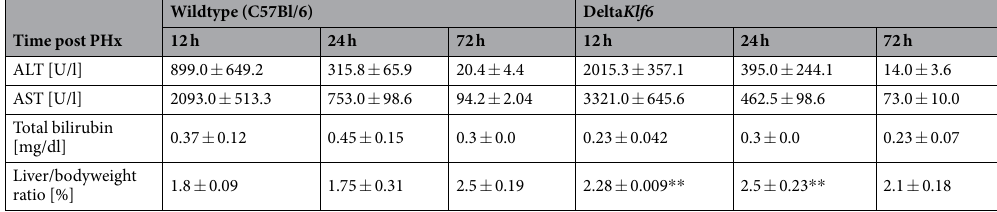
Table 1. Data from 12 h, 24 h or 72 h after partial hepatectomy (PHx) in wildtype or Delta Klf6 mice. ** p < 0.01 (wt vs. Delta Klf6 at same time-point).